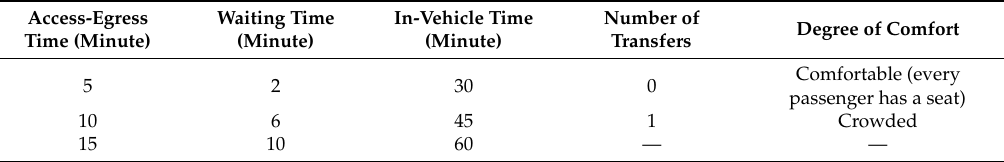
Table 3. Public transport service indicators and corresponding service levels.